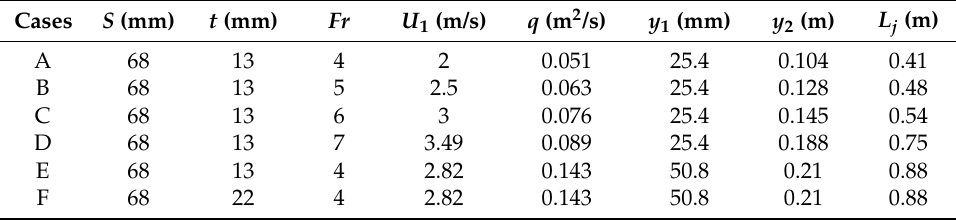
Table 1. Parameters of the numerical